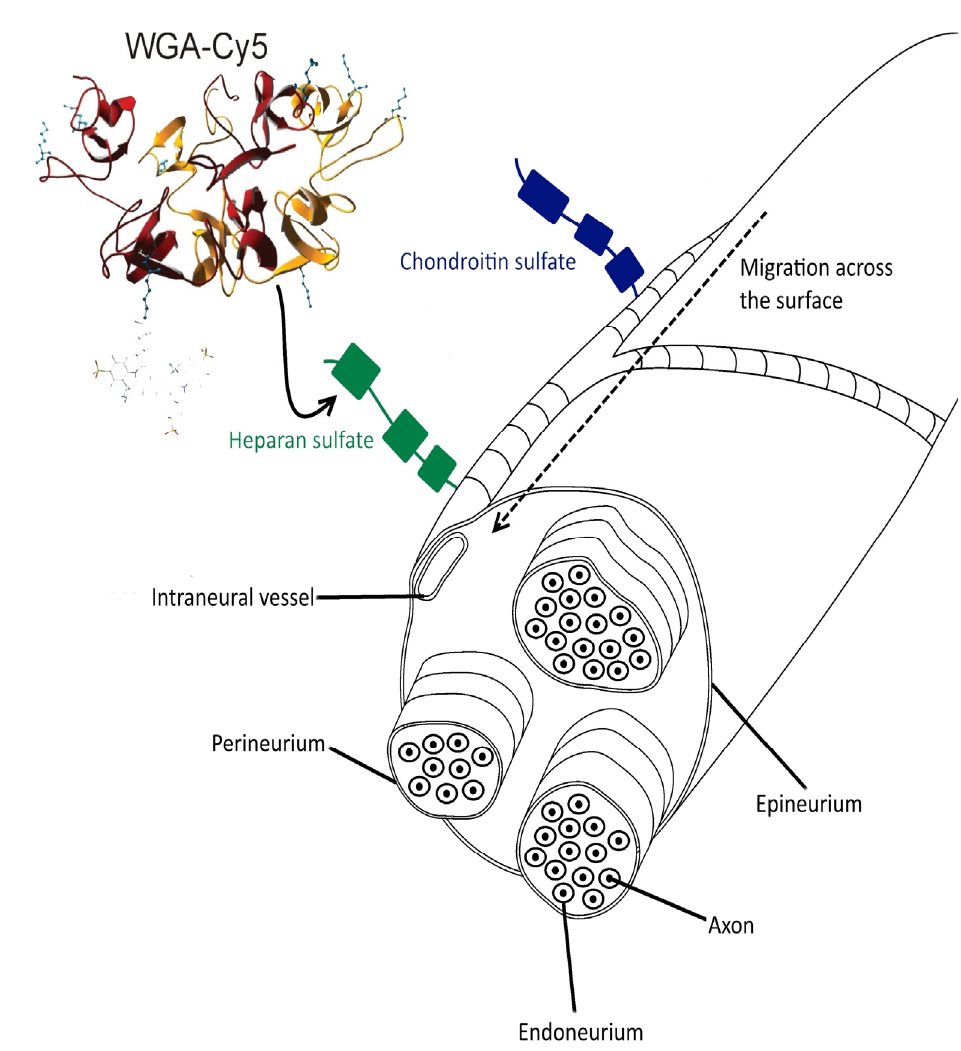
Figure 5. Schematic overview peripheral nerve wherein Cy5/ WGA lectin binds to PG’s located on the epineurium and extracellular